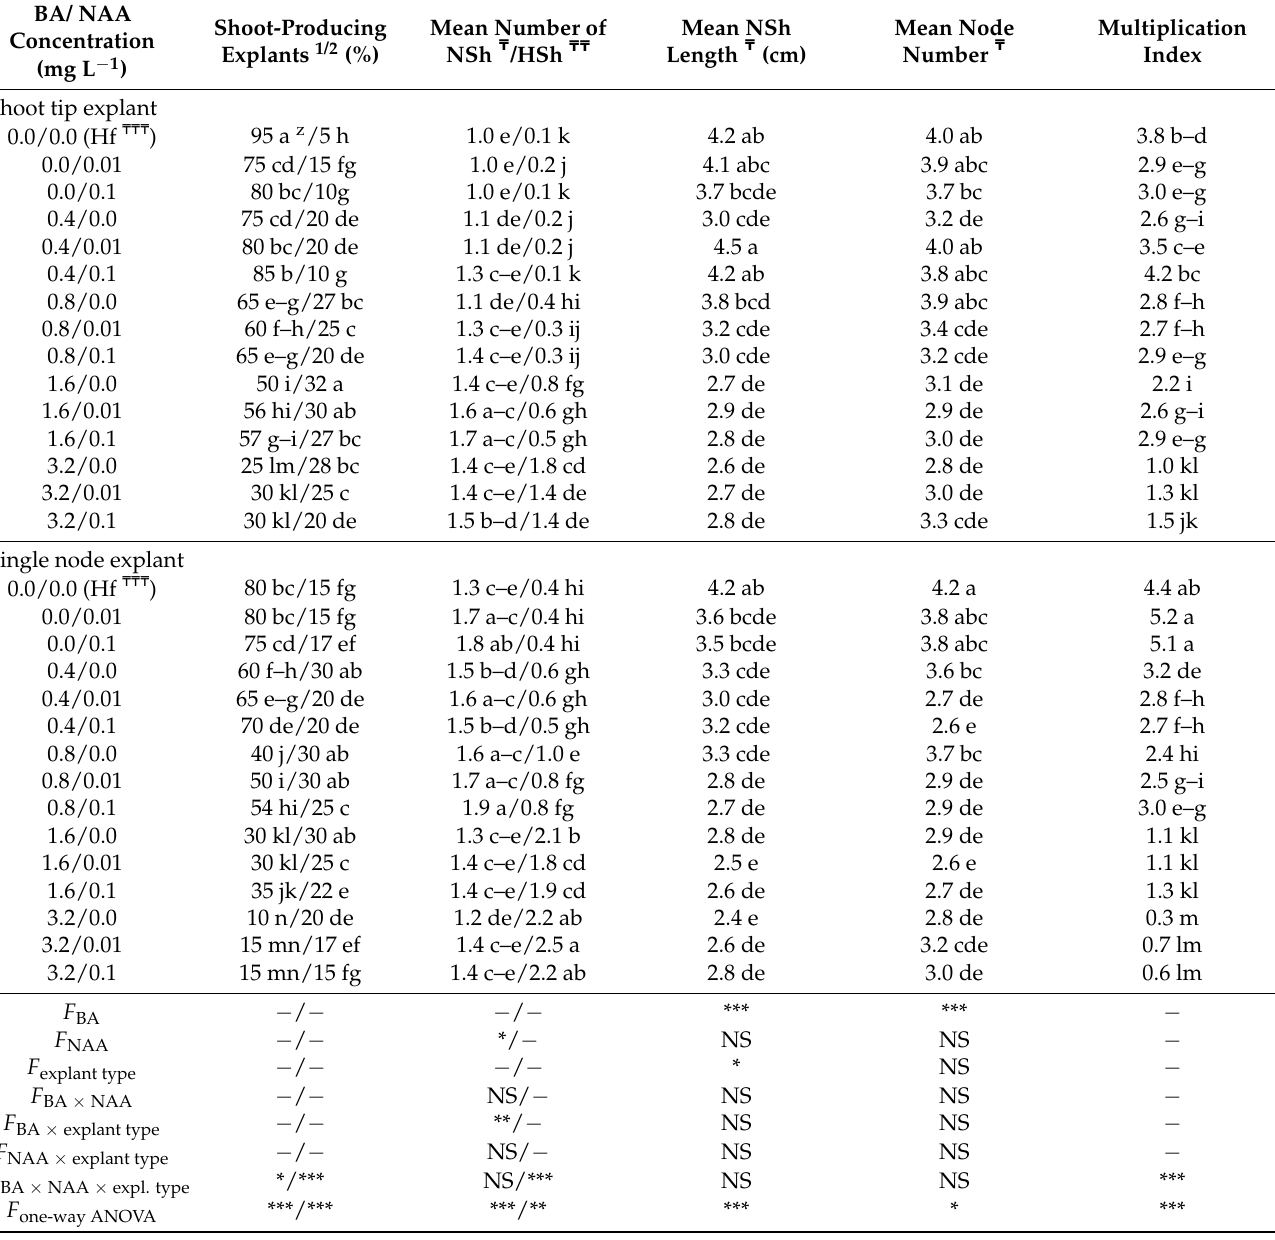
Table 1. Effect of season and origin and type of explant on axillary shoot production of S. tomentosa Table 4. Effect of plant-growth regulator type and concentration and explant type on axillary shoot Table 2. Effect of explant origin and plant growth regulators in the medium on axillary shoot pro- Table 2. Effect of explant origin and plant growth regulators in the medium on axillary shoot pro- Table 2. Effect of explant origin and plant growth regulators in the medium on axillary shoot pro- at the in vitro culture establishment stage on a hormone-free MS medium. liferation of S. tomentosa shoot tip and single node explants (mixed) at subcultures (means of six liferation of S. tomentosa shoot tip and single node explants (mixed) at subcultures (means of six liferation of S. tomentosa shoot tip and single node explants (mixed) at subcultures (means of six proliferation of S. tomentosa explants excised from cultures originated from in vitro seedlings. Explants subcultures). subcultures). subcultures).